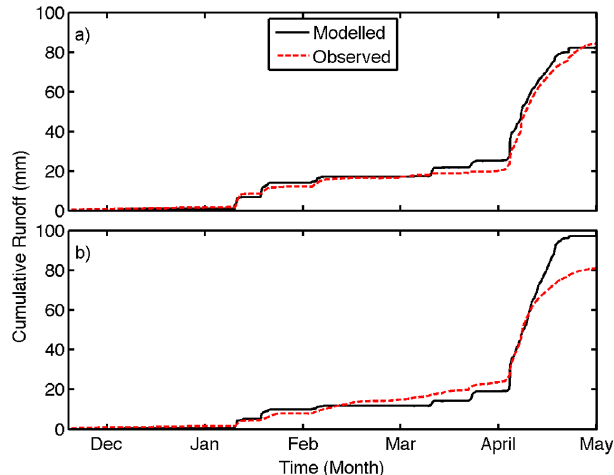
Figure 8. As Fig. 7 for Montreal in 2008–2009 (a) suburban site with observations above (grass) lawn and (b) urban site with (build- ing) roof observations. The grey area shows the spin-up